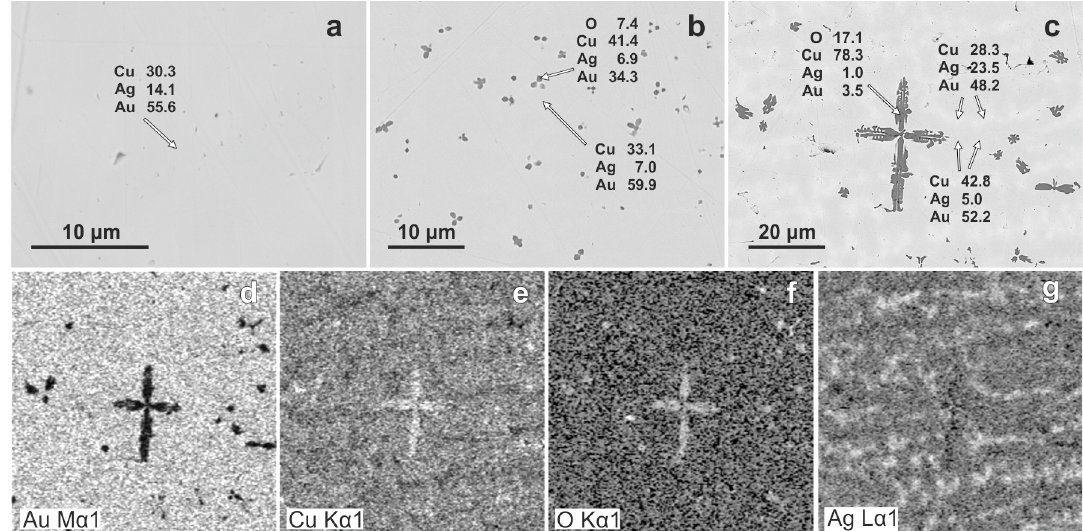
Figure 16. EDS images for Cu-Ag-Au spherules obtained in oxygen-free ( a ) and at atmospheric conditions ( b , c ) experimental runs with water quenching ( a , b ) and free air cooling ( c ); ( d – g )—results of scanning of cross-section ( c ) in characteristic Au M α 1 ( d ), Cu K α 1 ( e ), O K α 1 ( f ) and Ag L α 1 ( g ) rays.